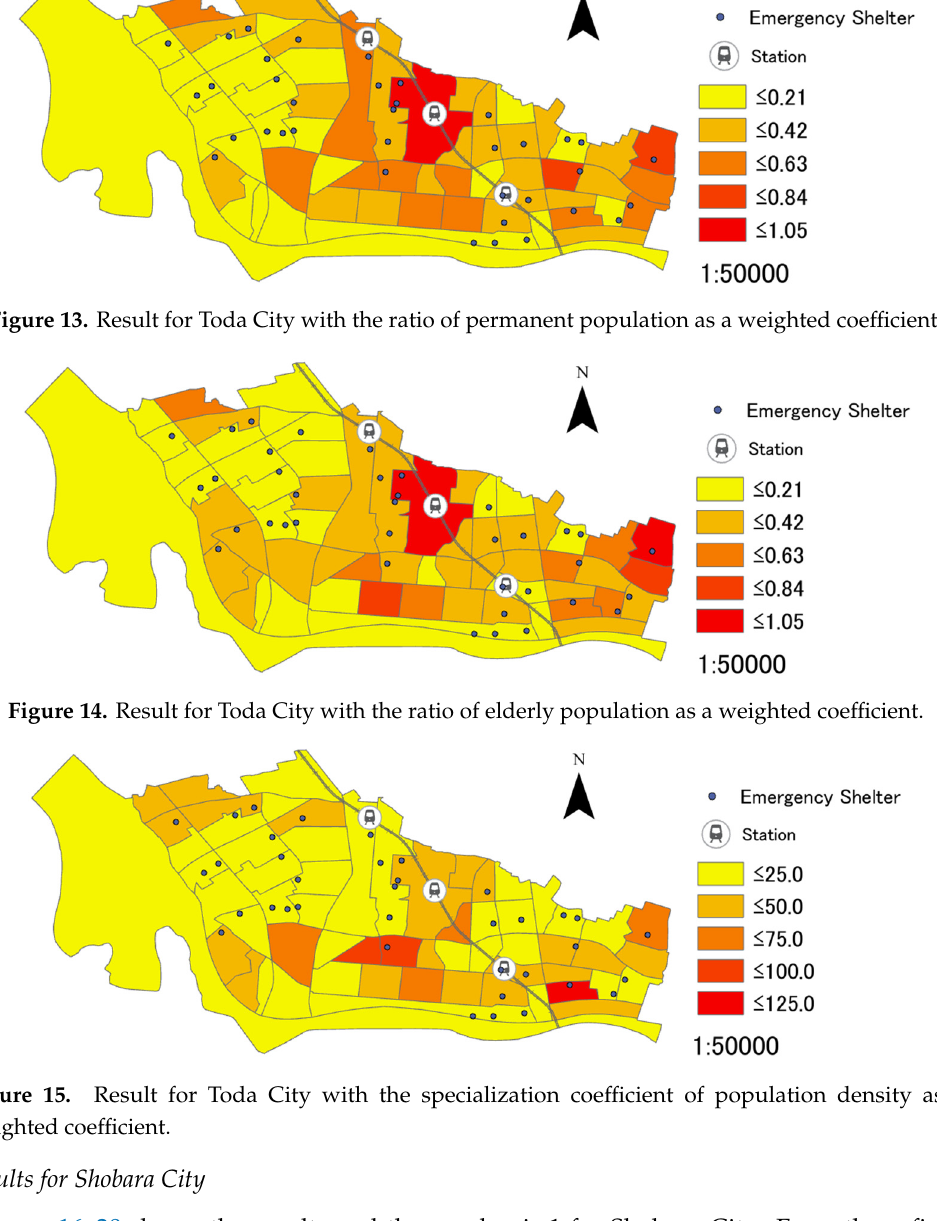
Figure 12. Result for Toda City with the specialization coefficient of elderly population as a weighted coefficient.